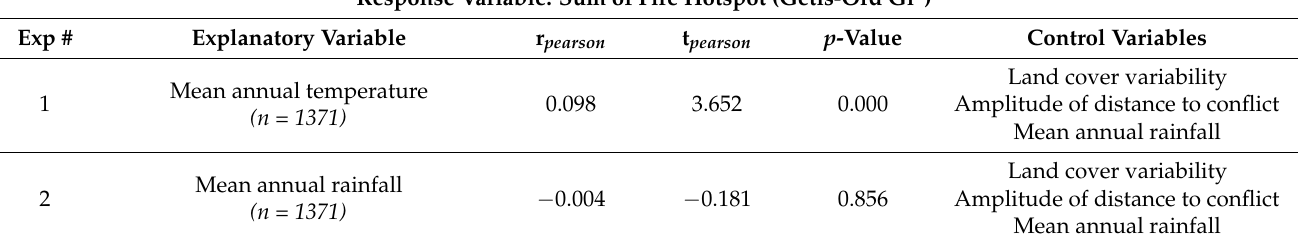
Table 2. Results of six partial correlation experiments. The response is the focus variable whose variation is being studied. The response variable in this analysis is the sum of hotspot anomalies within each 10 km fishnet cell across the study area. The explanatory variables are also captured within each 10 km fishnet cell and are those that could have an impact on the variability of the response. Amplitude of distance to conflict is the range of distance values from a conflict location; land cover variability is the diversity of land cover pixels. The control variables are those whose effects are masked in each experiment. Note that the value of n varies with the number of interaction terms